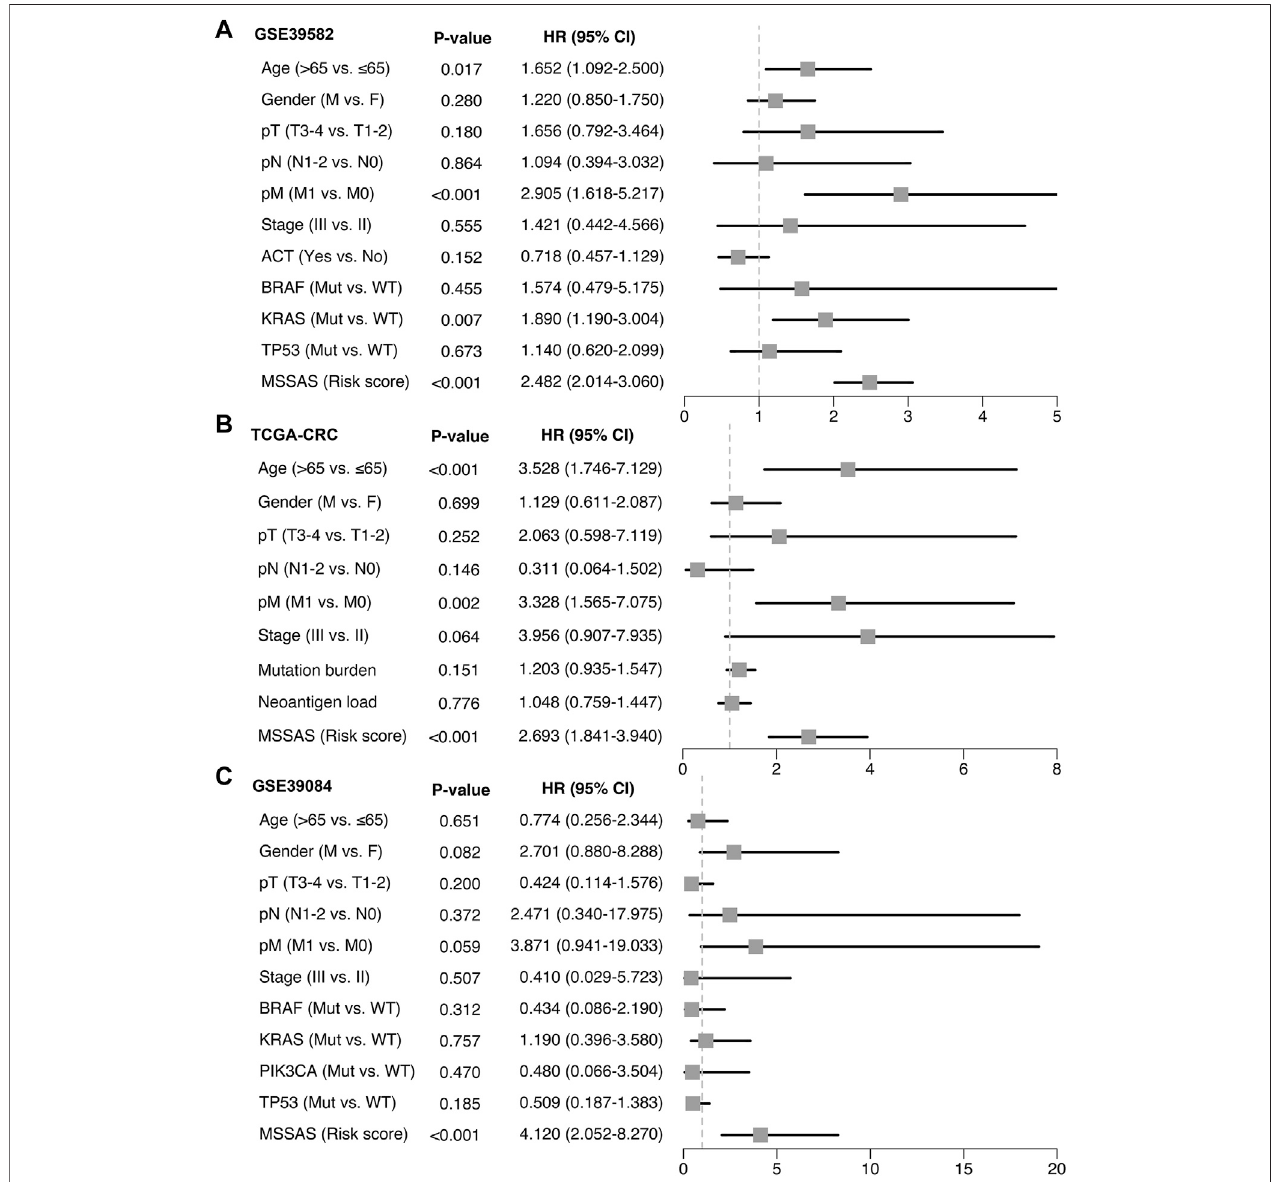
FIGURE 4 | Multivariable Cox regression analysis of OS. Multivariable Cox regression analysis of MSSAS for OS in GSE39582 (A) , TCGA – CRC (B) , and GSE39084 (C) .